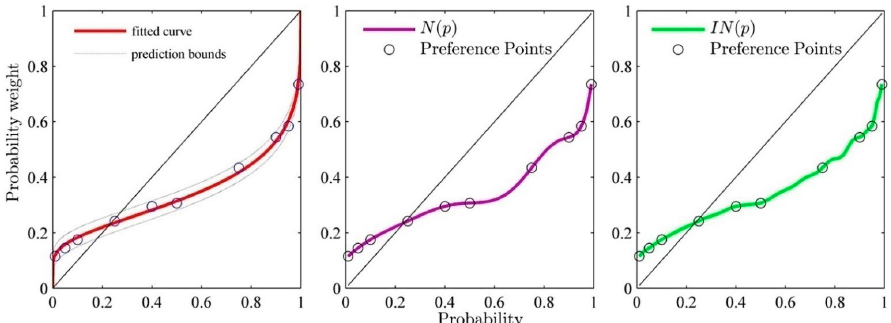
Figure 11. PWF curves based on aggregate data except for preference points (0.6,